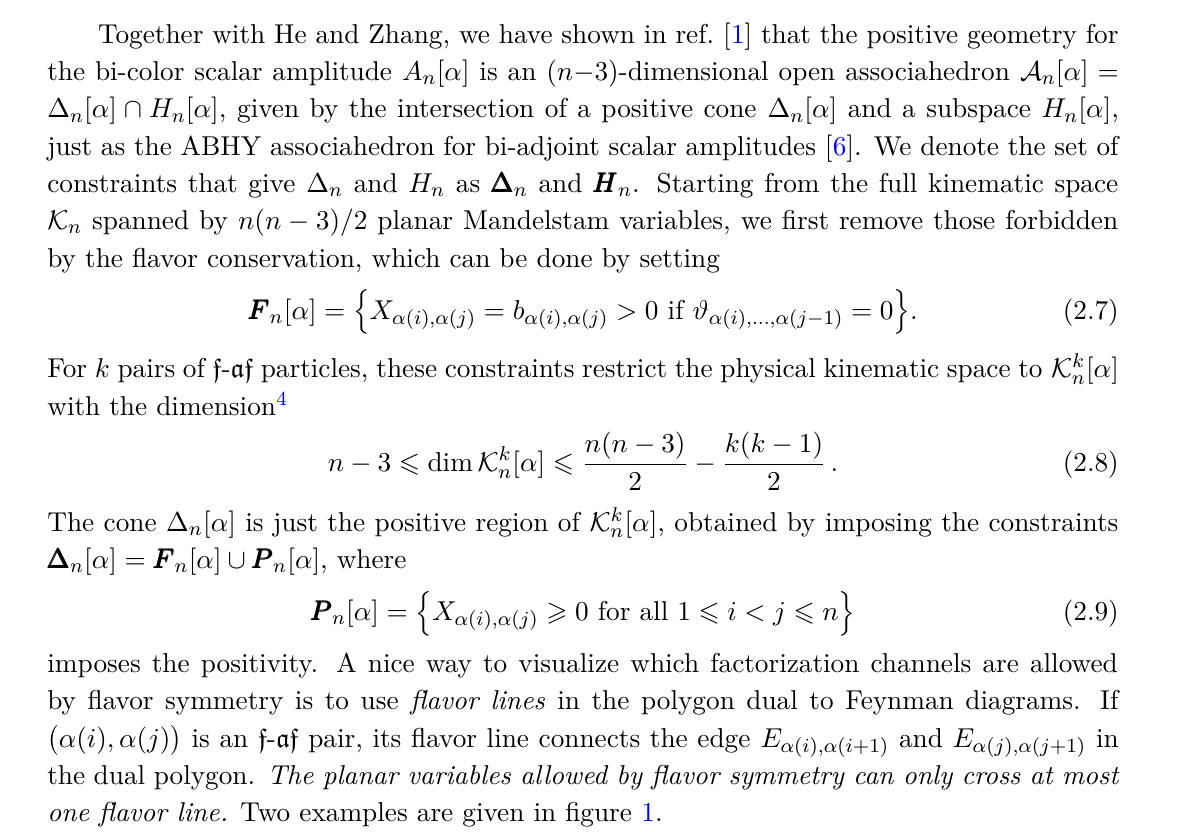
Figure 1 . Example of flavor lines taken from ref. [1]. The gray curves are the flavor lines associated with the f - af pairs. The red dashed lines are the planar variables forbidden by flavor symmetry. The blue solid lines are a few representatives of allowed planar